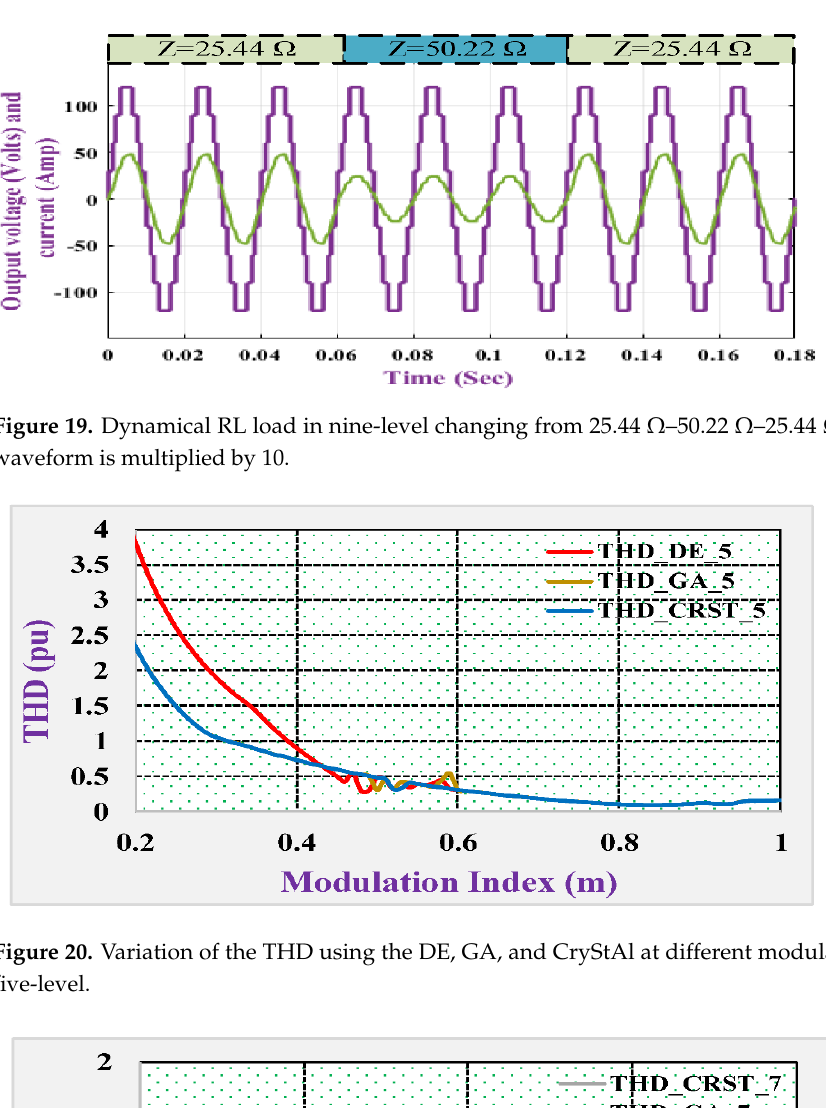
Figure 18. Dynamical RL load in seven-level changing from 25.44 Ω– 50.22 Ω– 25.44 Ω. The current waveform is multiplied by 10.